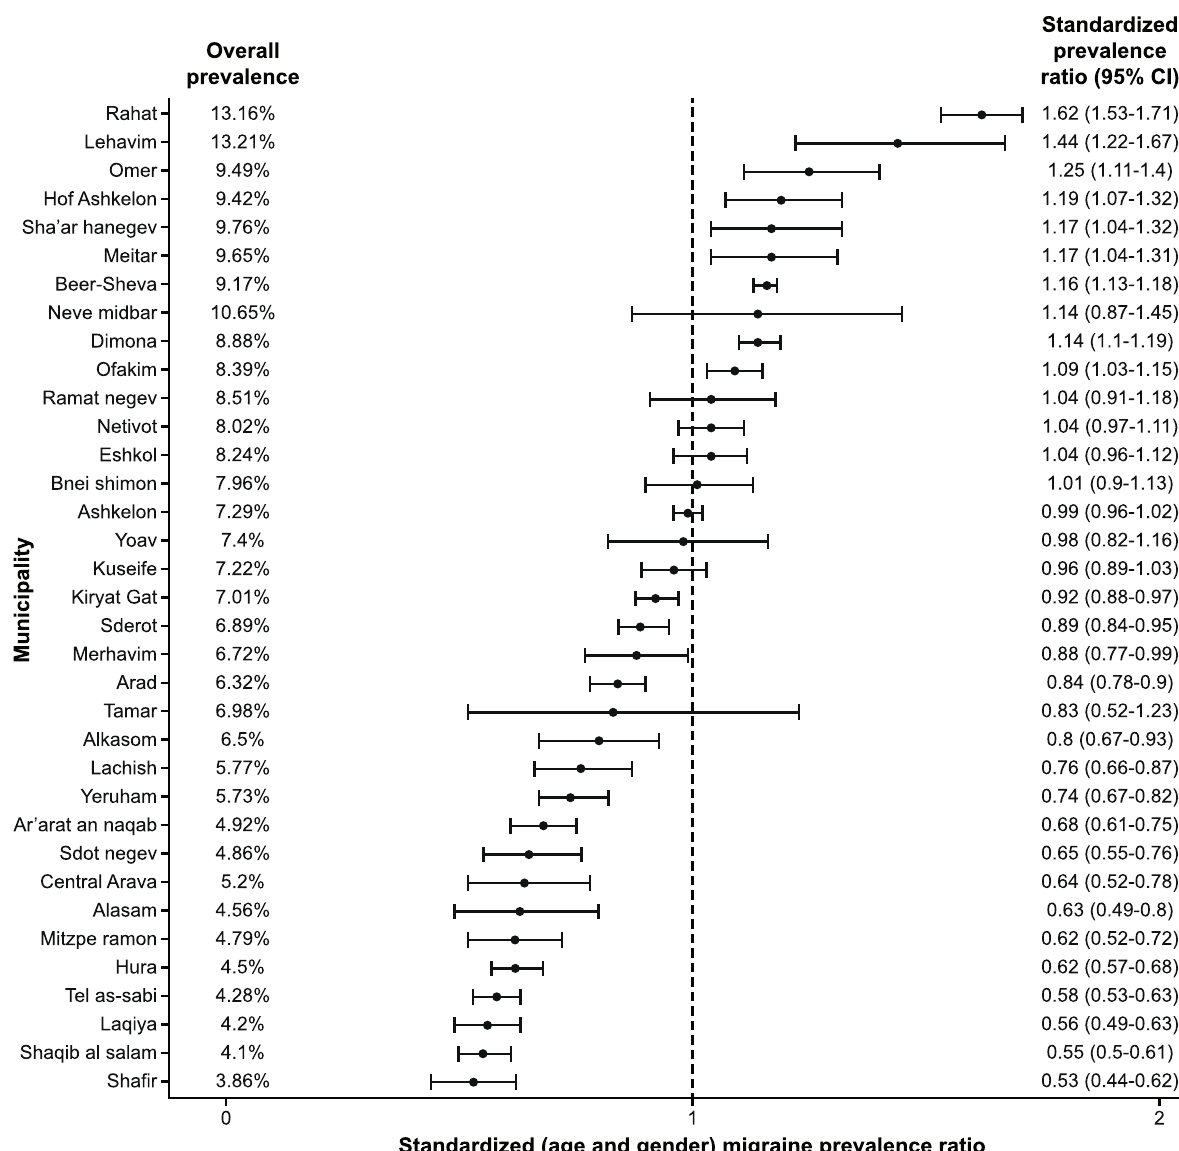
Fig. 2 Standardized (age and gender) prevalence ratios (SMR). SMR, standardized mortality ratio; CI, confidence